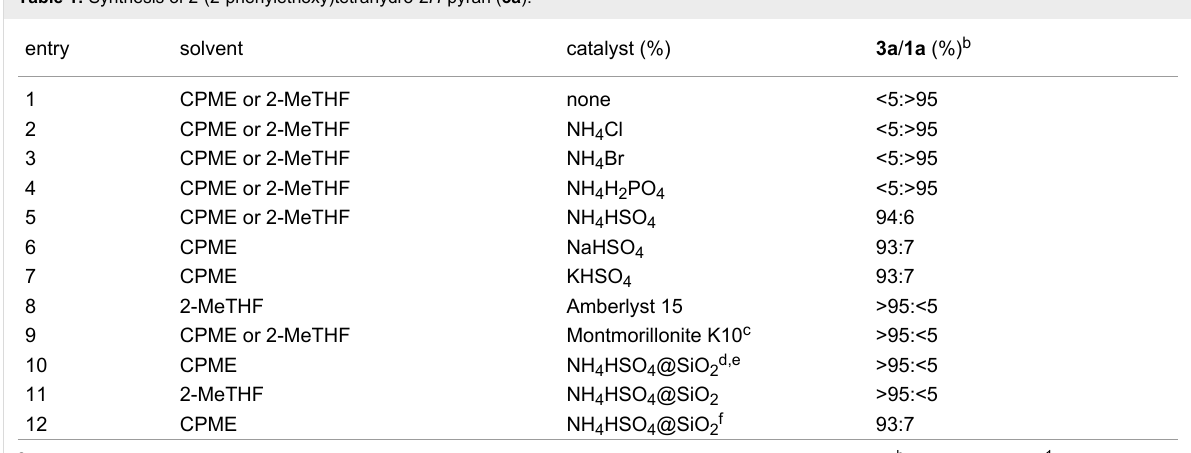
Table 1: Synthesis of 2-(2-phenylethoxy)tetrahydro-2 H -pyran ( 3a ).